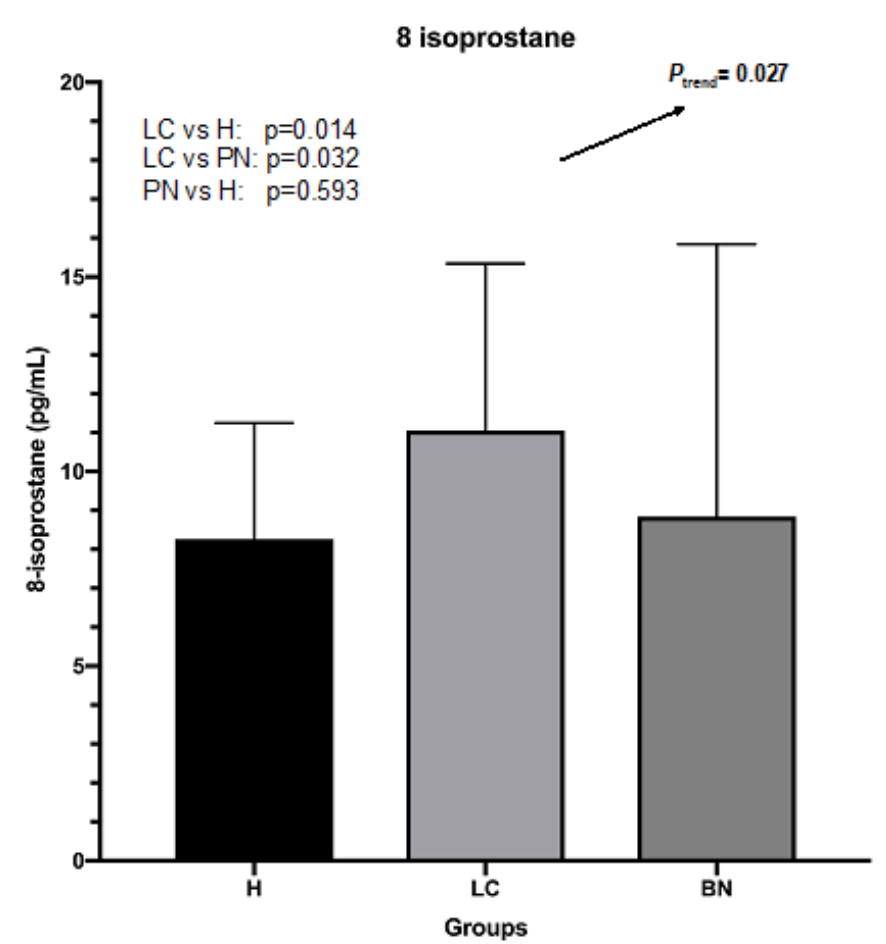
Figure 2. Levels of plasma 8-isoprostane in lung cancer, benign nodules, and control groups. The AUC is 0.69, indicating that the level of plasma 8-isoprostane has diagnostic value for distinguishing the presence of lung cancer from benign nodules (Figure 3). In linear regression analysis, there was a significance difference in levels between the lung cancer and benign nodule group ( p = 0.002) after adjustment for sex, age, and other poten- tial confounders. The ROC that compared the lung cancer group to the controls had an AUC of 0.70.